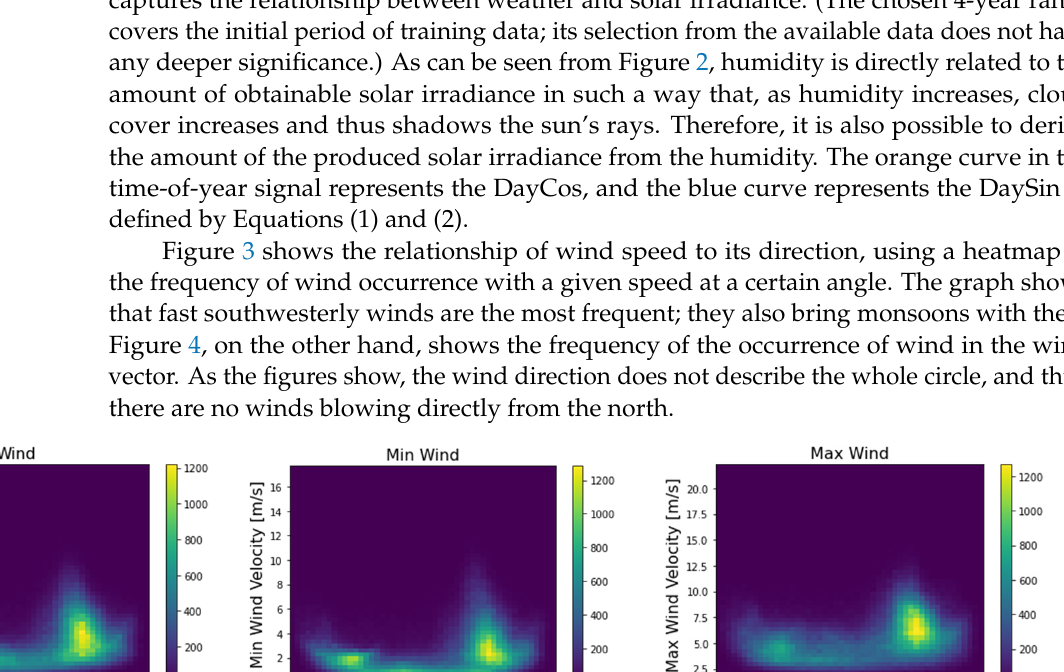
Figure 4. Visualization of the frequency of occurrences of wind characteristics by wind vector. 2.4. Transformer Model for Solar Irradiance The Transformer model is a neural network architecture used typically for natural lan- guage translation. Its basic element is the attention mechanism, which links related features in sequential data. Transformer is composed of basic parts, which are self-attention blocks and position-wise fully connected feed-forward network blocks. Self-attention blocks are formed